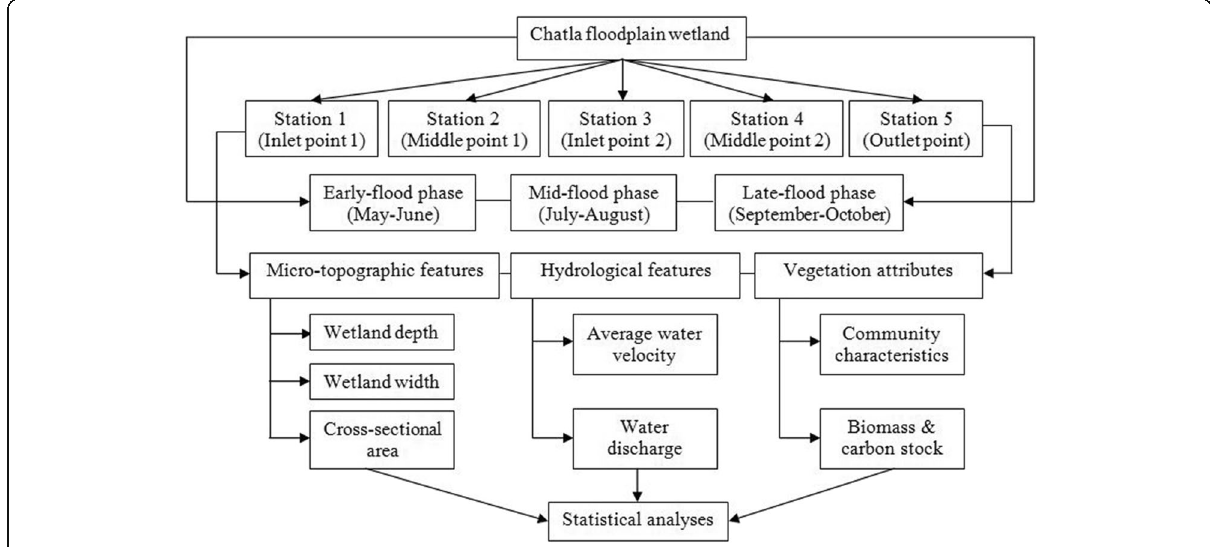
Fig. 3 Methodological framework of the present study